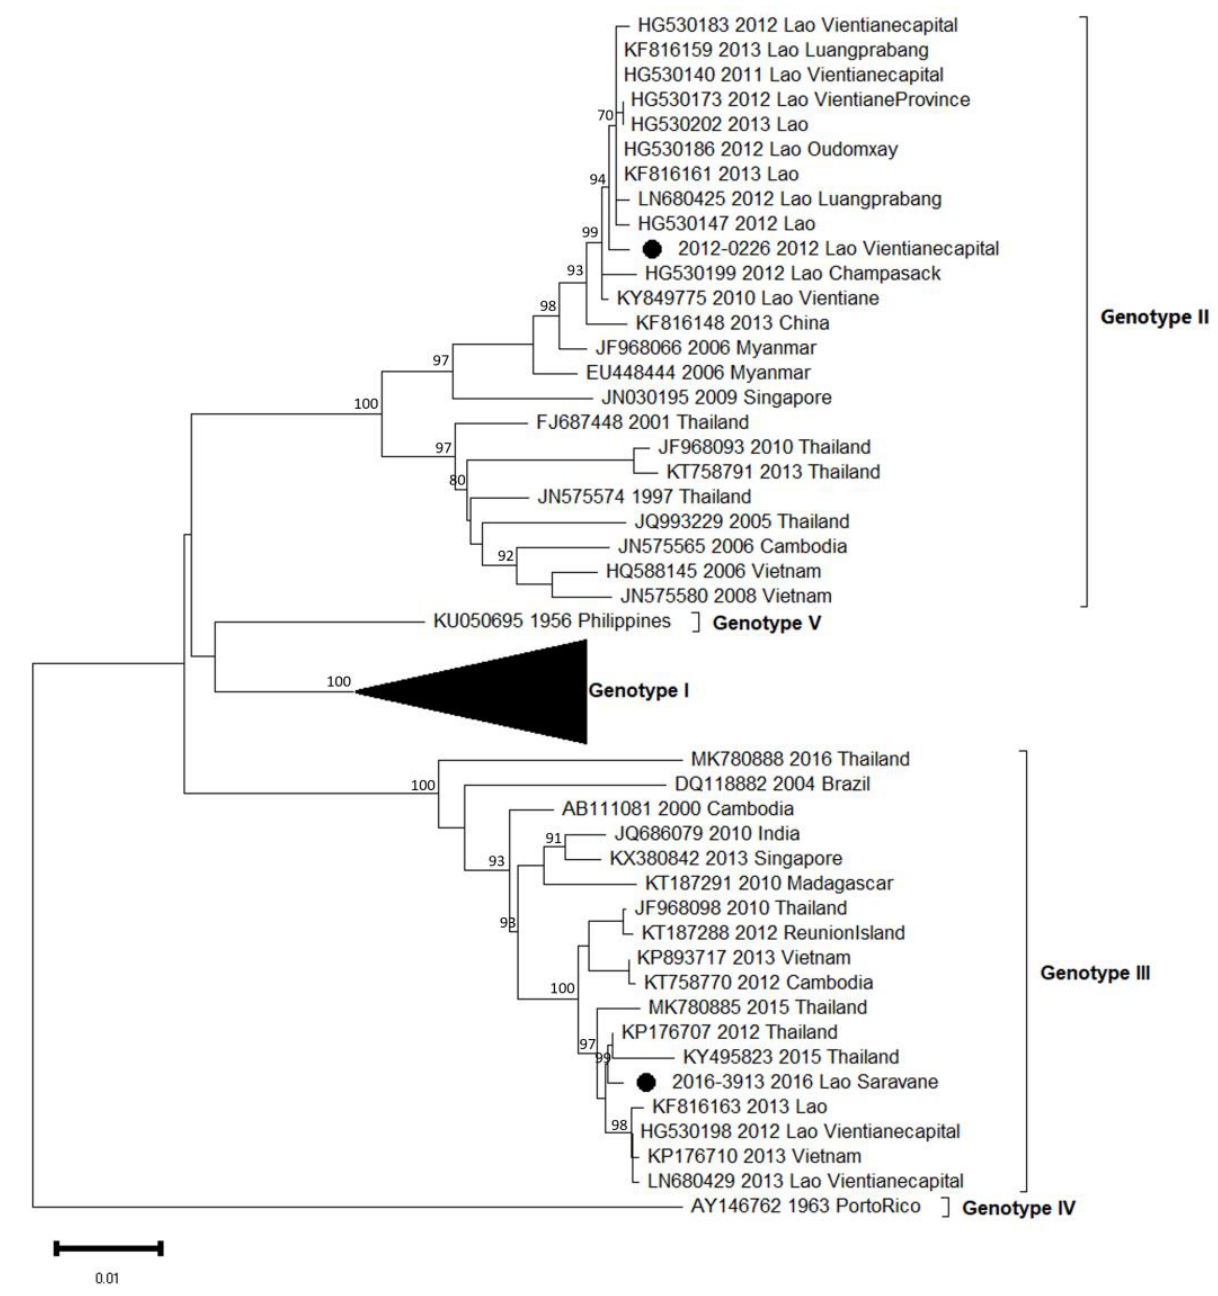
Figure 5. Phylogenetic analysis of DENV-3: 53 complete CDS protein E references of DENV-3 were selected from GenBank and aligned with the 2 DENV-3 sequences from this study (indicated with black circle). Multiple sequence alignments were obtained using MAFFT version 7.023b. The unrooted phylogenetic trees were constructed using RAxML with general time-reversible plus gamma distribution substitution model and a rapid bootstrap (i.e., model GTR + I + G, bootstrap = 1000). The major genotypes and lineages in which sequences from this study are grouped are indicated. Statistical support values of grouping (maximum-likelihood bootstrap replicates >60%, as calculated by RAxML) are indicated at nodes of the tree. Scale bar indicates nucleotide substitution per site.